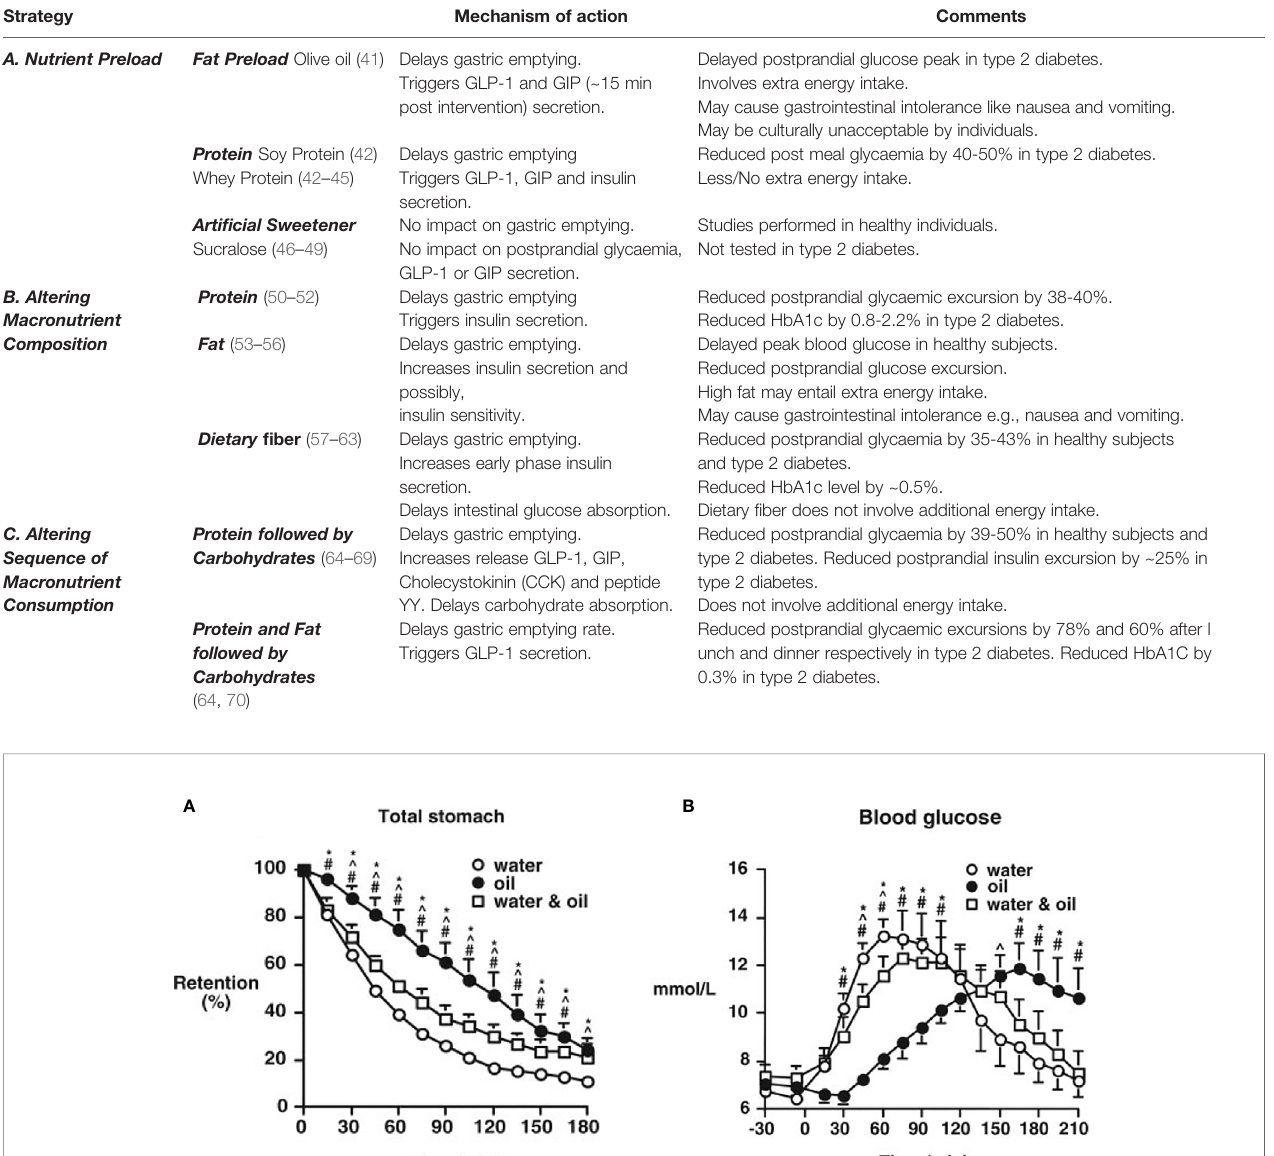
TABLE 1 | Dietary approaches to reduce postprandial glycaemia.